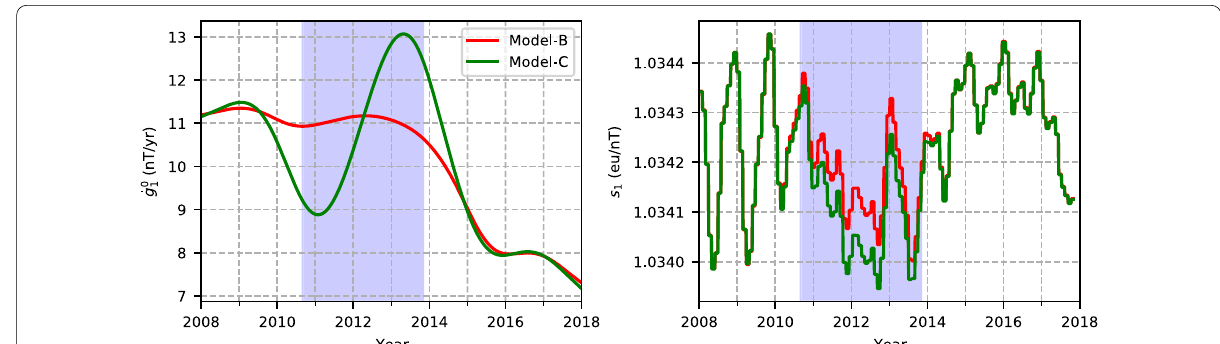
Fig. 6 Time-derivative of g 0 1 (left) and sensitivity s 1 for GRACE-A as computed from Model-B and Model-C (right). For Model-C, we allowed nightside platform magnetometer data to contribute to the estimation of the internal g 0 1 Gauss coefficient. The gap period between CHAMP and Swarm is indicated as a blue-shaded region (Sep 2010 to Nov 2013)